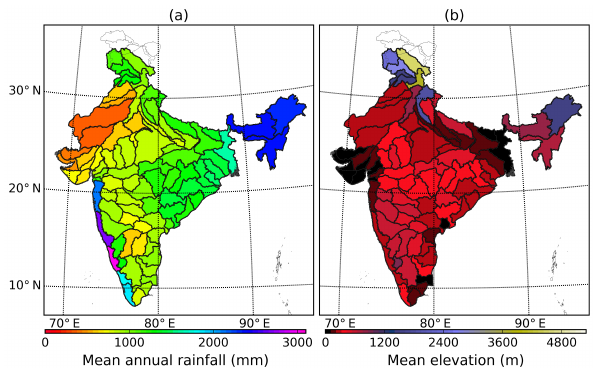
Figure 2. Spatial distributions of (a) long-term average annual rain- fall (calculated from IMD gridded rainfall dataset during 1980– 2010) and (b) average elevation above mean sea level (calculated using SRTM DEM) over 86 delineated river basins across